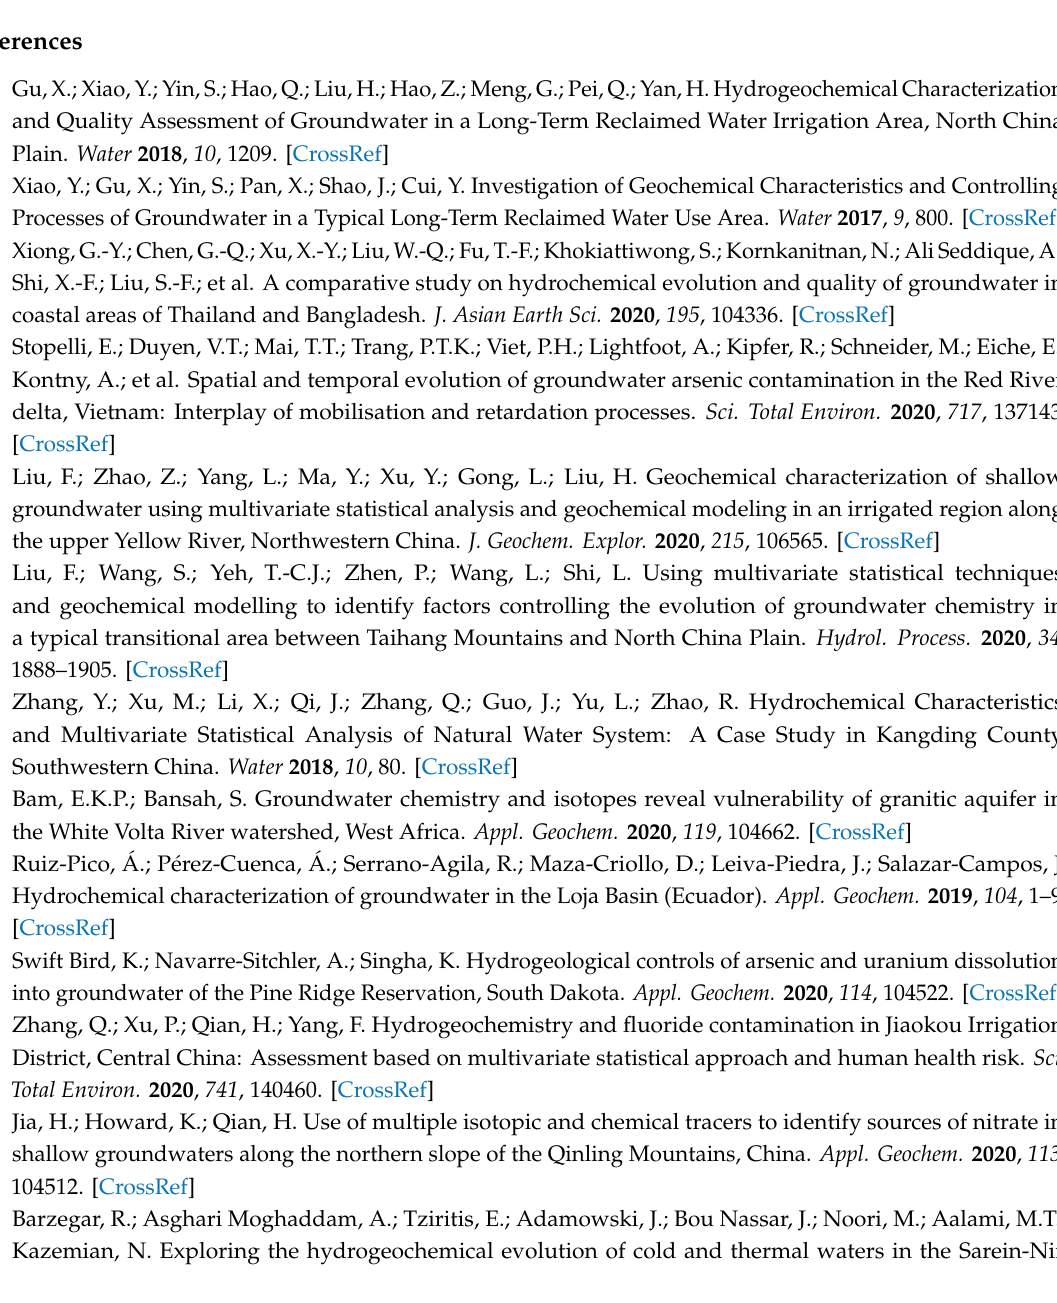
Figure S1: Dendrogram for the groundwater samples, showing the two groups and the mean concentration Sti ff diagram of each group, Table S1: Experimental data for groundwater samples in main urban area of Chongqing, Table S2: Saturation indices of groundwater samples in main urban area of